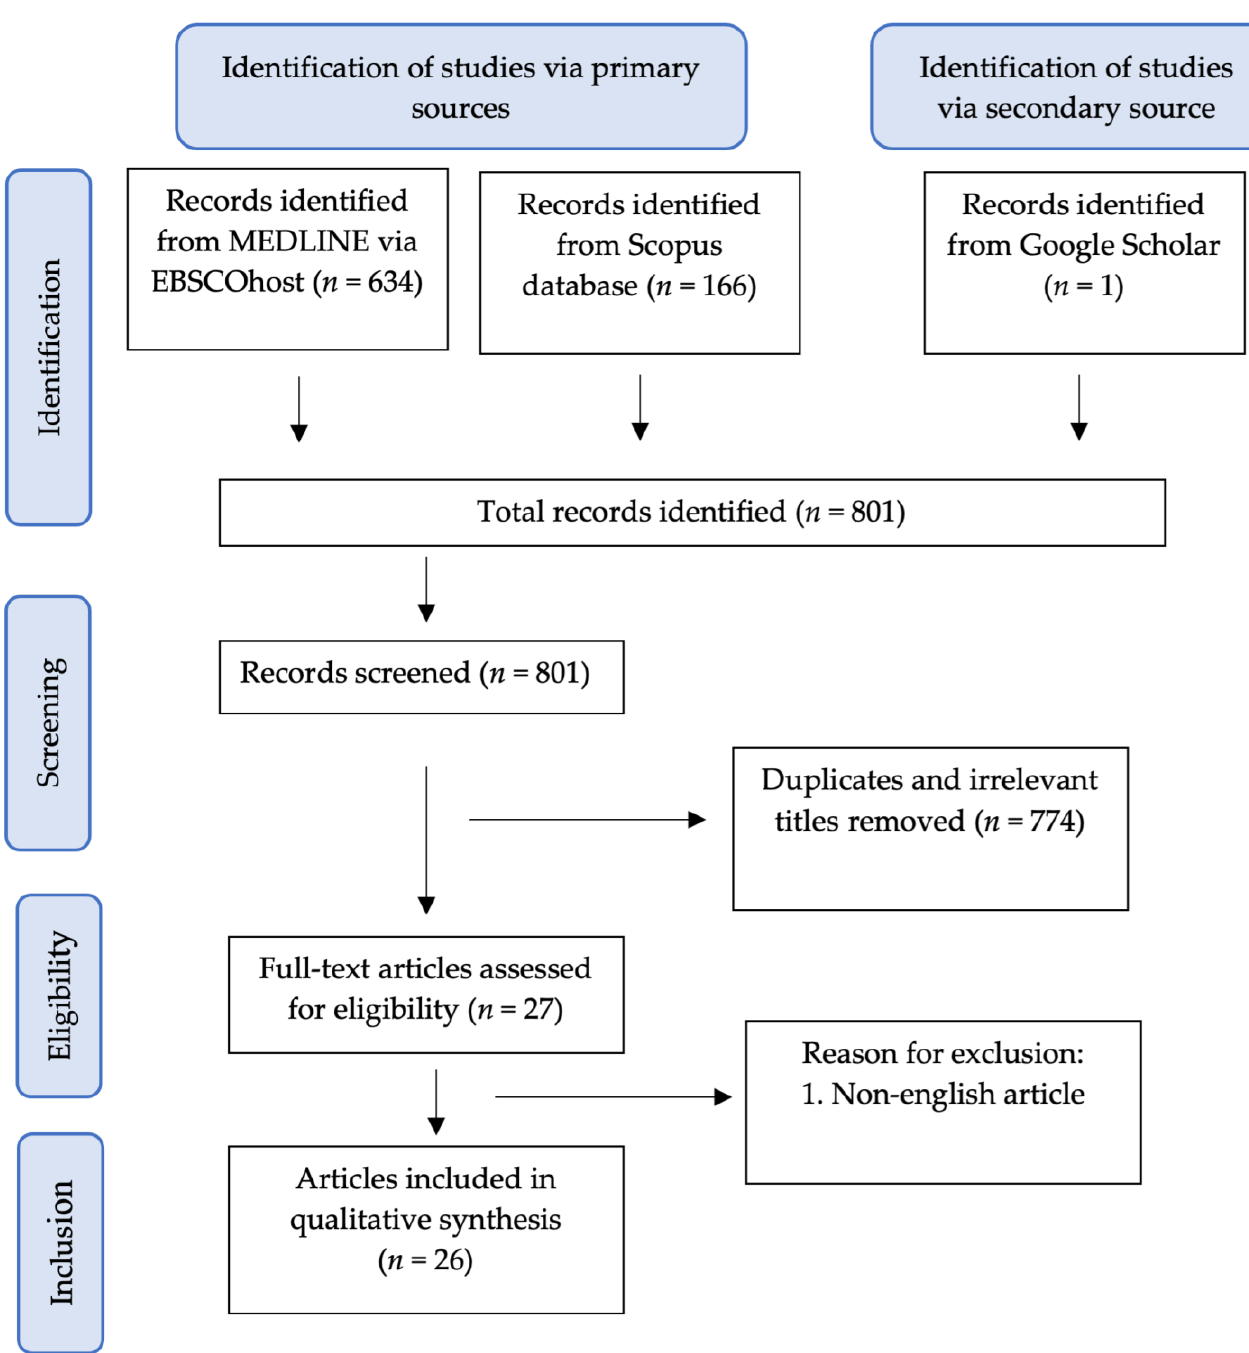
Figure 4. Flowchart of the article selection process.